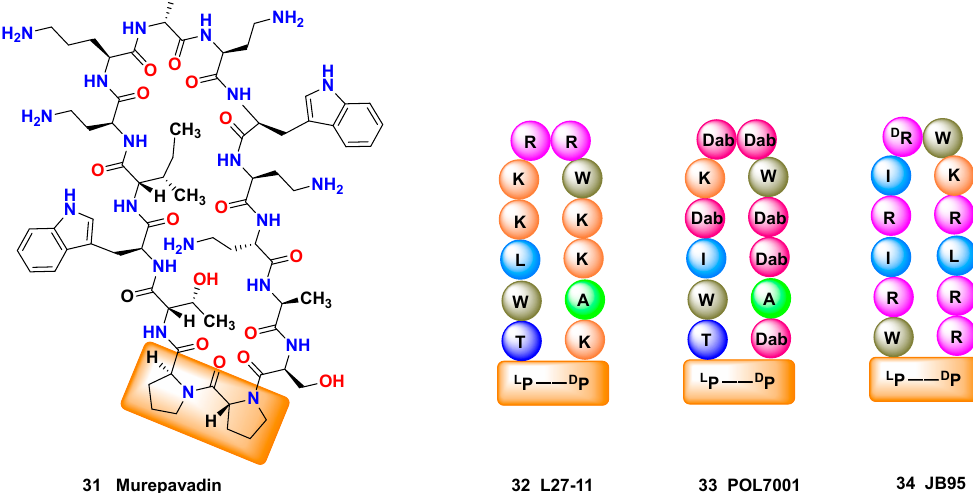
Figure 4. ( Left ) Murepavadin ( 31 ), an anti-pseudomonas peptide in Phase II trials, with a L -Pro- D -Pro unit that induces a β -turn in the β -hairpin structure; ( Center ) The 12-residue β -hairpin mimetic L27-11 ( 32 ) with a potent and specific antipseudomonas activity; optimization of this hit generated POL7001 ( 33 ) (Dab = L -2,4-diaminobutyric acid); ( Right ) Another synthetic peptidomimetic antibiotic JB-95 ( 34 ), active against E. coli .